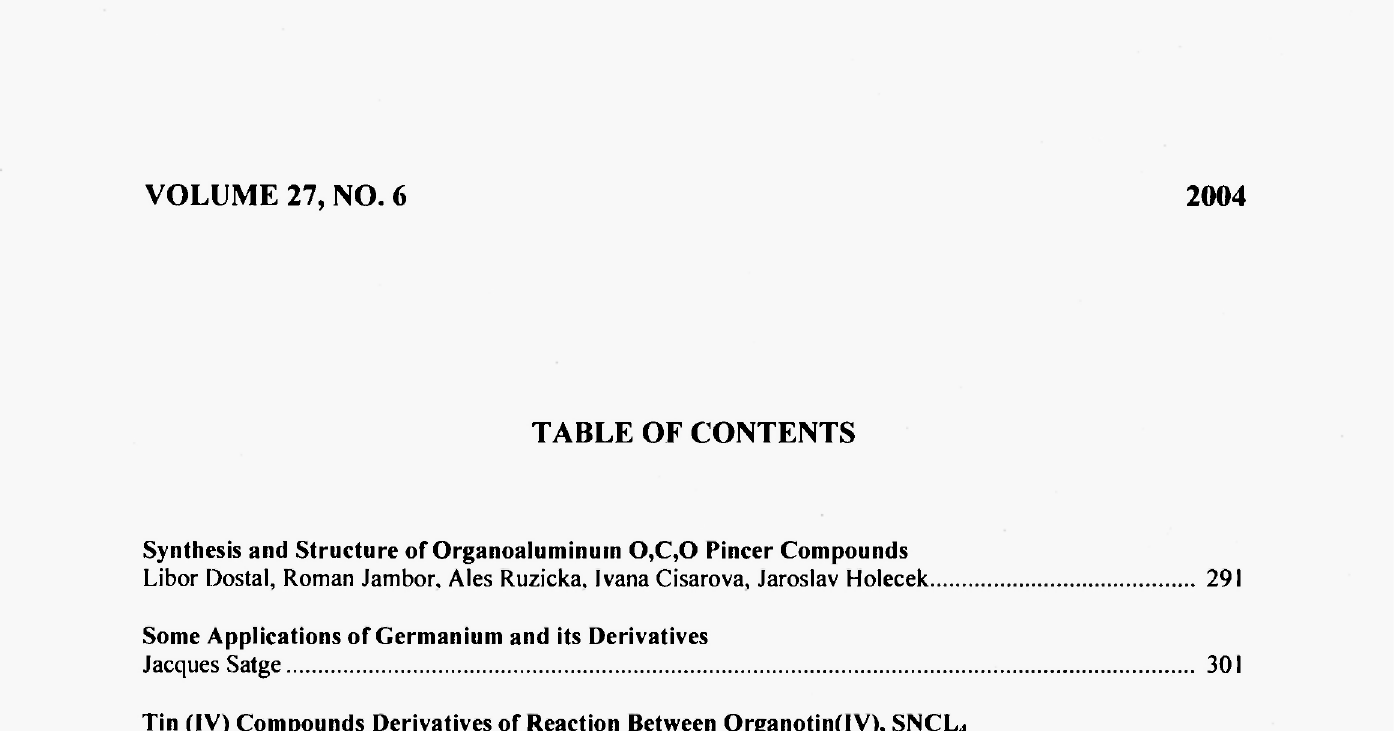
Synthesis, Characterization & Thermal Studies of Some Dithiocarbazate Schiff Bases- Organotin(IV), Organozinc(ll)